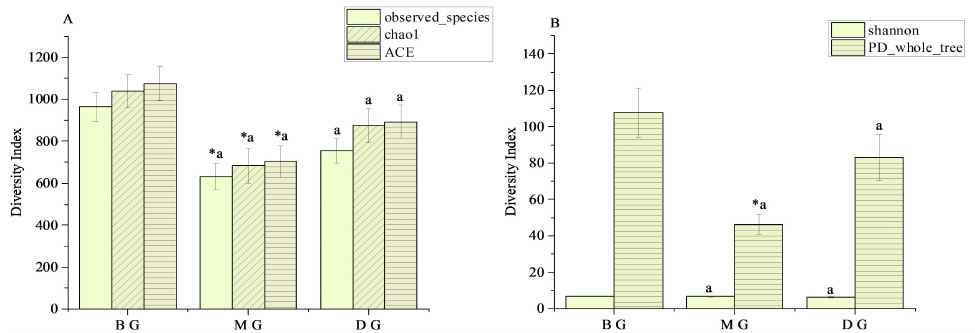
Figure 1. Alpha Diversity index statistics. ( A ) Species richness index; ( B ) Species diversity index. * indicates significant difference between the means of the MG group and the BG group ( p < 0.05), and the different lowercase superscript letters indicate that the means of the MG group and the DG group are statistically significant ( p < 0.05). Data were presented as mean ± standard deviation, calculated from three